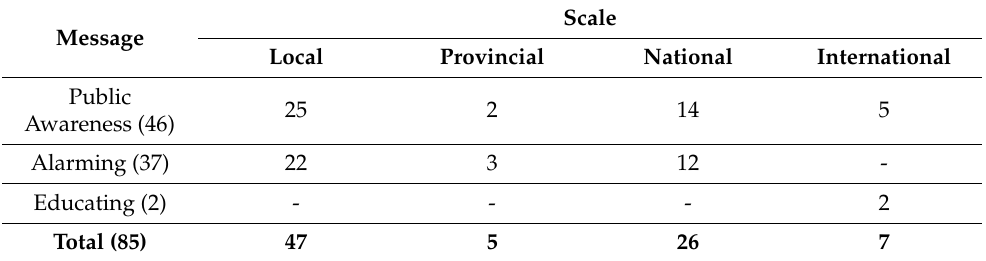
Table 6. Number of water-related messages at different spatial levels (n = 85).